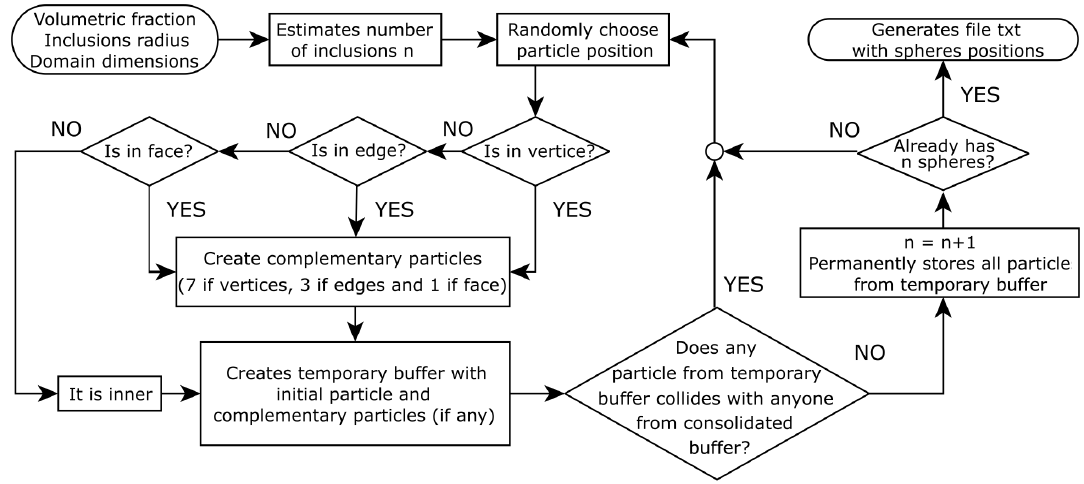
Figure 7. Flow chart describing the process to insert the inclusions into the cubic domain.